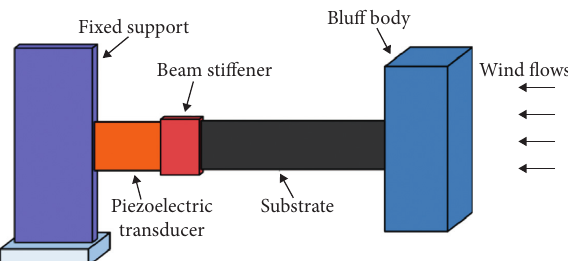
Figure 16: The prototype of energy harvester attached with a beam stiffener [49].